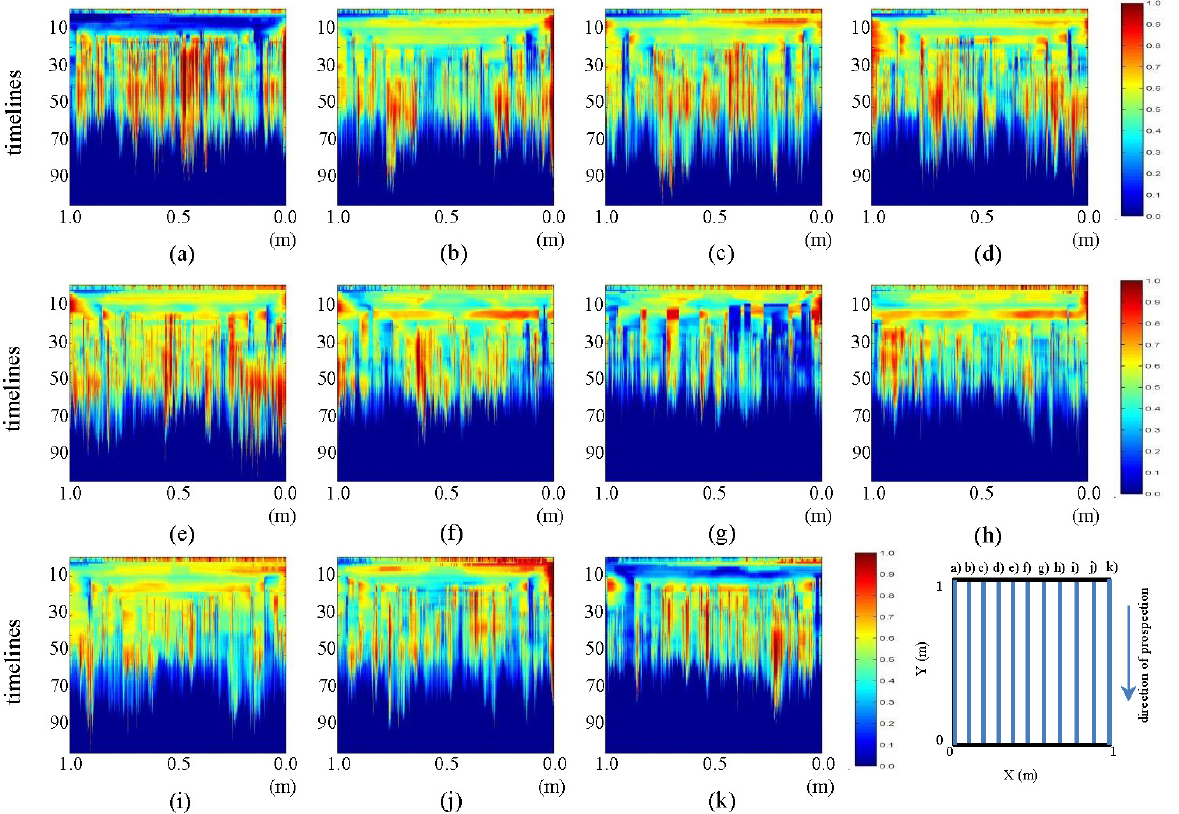
Figure 16. Vertical profiles: pre-processed images for the final state. ( a – k ) are profiles s12 to s22,